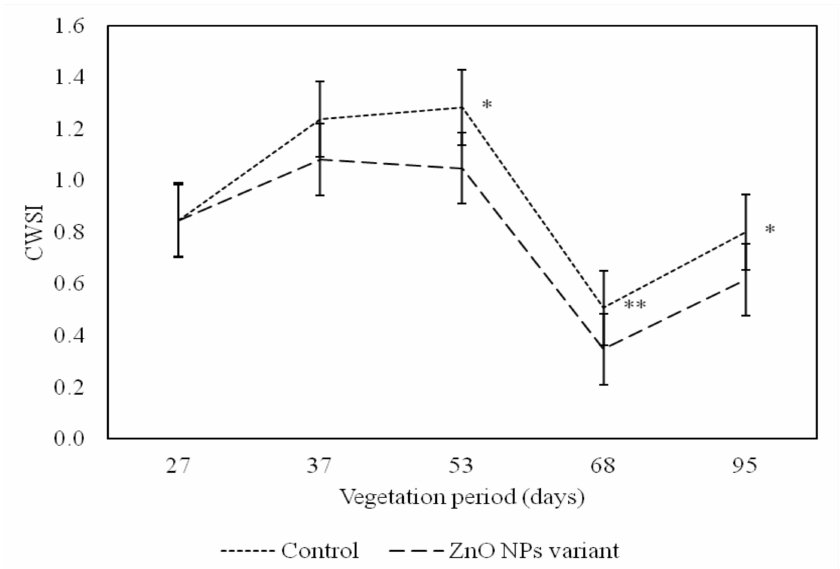
Figure 5. The e ff ect of foliarly applied ZnO NPs vs. control (without ZnO nanoparticle application) related to foxtail millet crop water stress index (CWSI) measured during the 2018 growth season. Significances are: * P value < 0.05, ** P value <